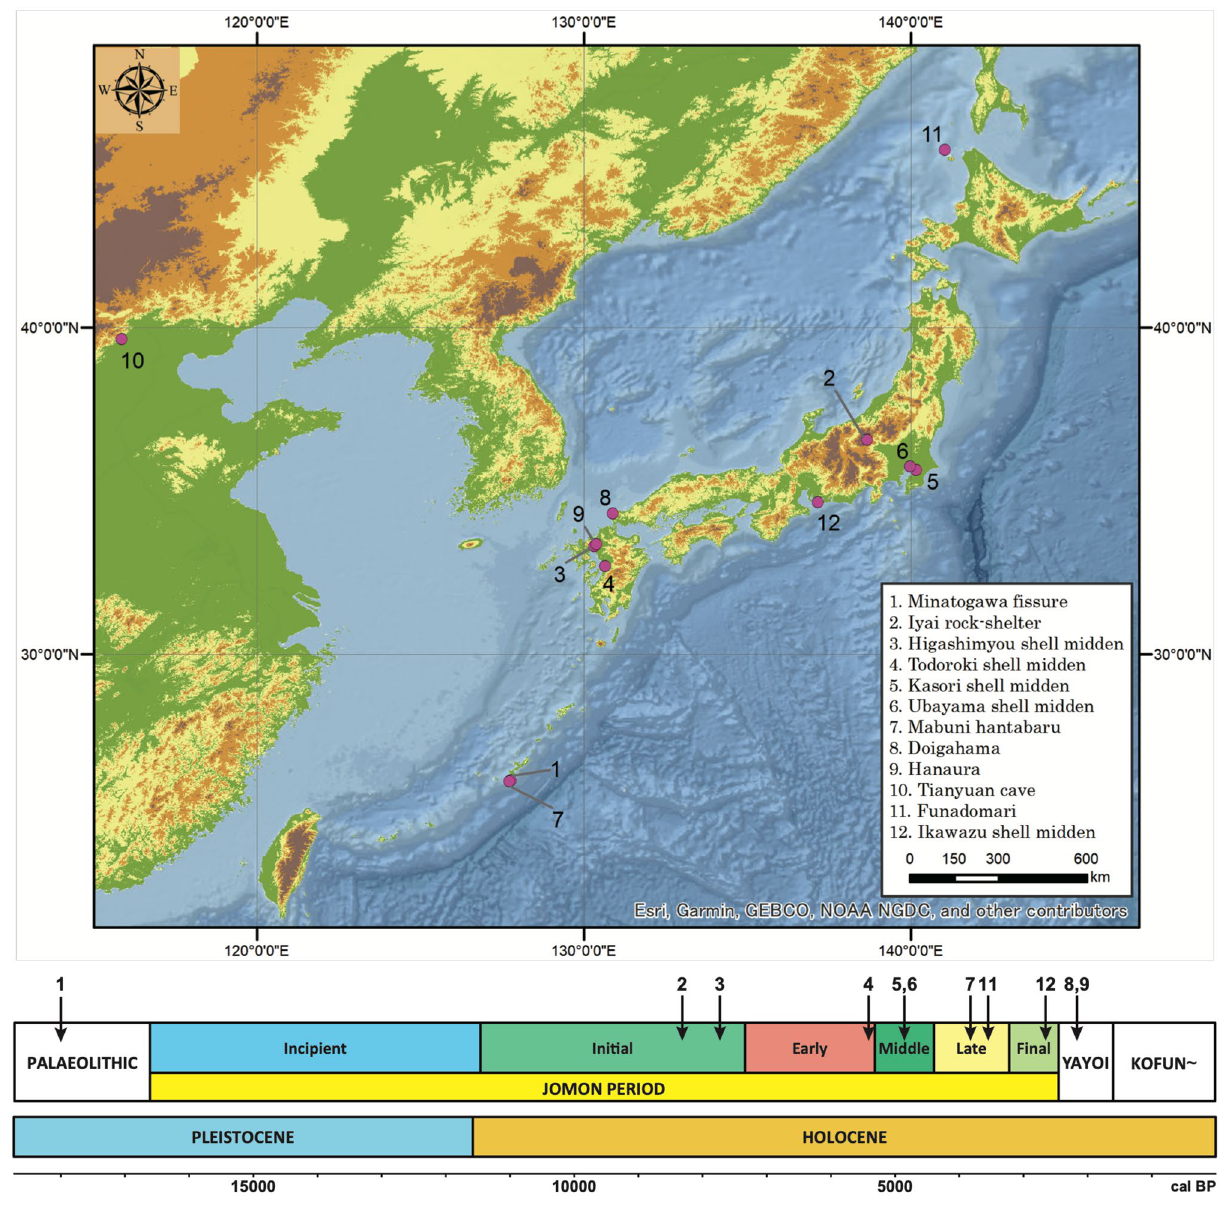
Figure 1. Late Pleistocene and Holocene archaeological sites in the Japanese Archipelago and mainland China. Only the sites where mitogenome sequences from human remains used in this study are shown. The known dates for each site are shown below. This figure was generated by Adobe Illustrator 24.1 (Windows) and ArcGIS Desktop 10.7.1 (https:// www. esrij. com/). The data was obtained from Consultative Group on International Agricultural Research Consortium for Spatial Information (CGIAR-CSI, https:// cgiar csi. commu nity/), CGIAR- CSI SRTM 90 m Database 53 (http:// srtm. csi. cgiar. org) and Ocean/World_Ocean_Base of ArcGIS map service (http:// servi ces. arcgi sonli ne. com/ arcgis/ servi